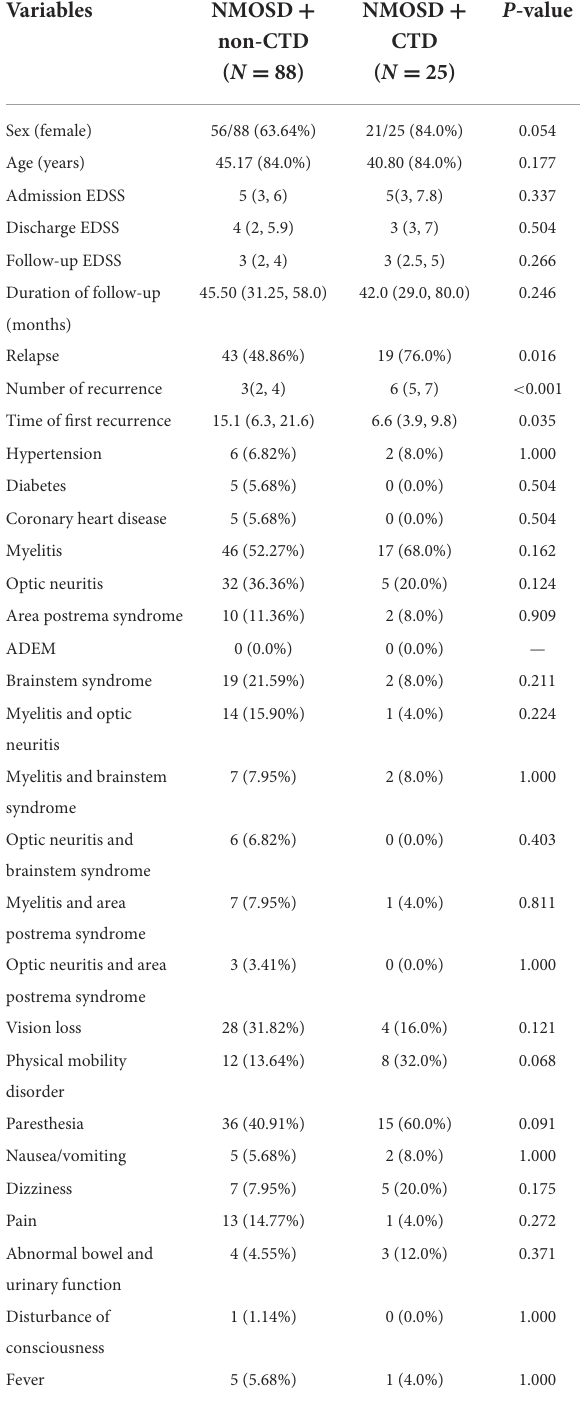
TABLE 3 Cerebrospinal fluid (CSF) analysis in patients of AQP4-positive NMOSD with and without